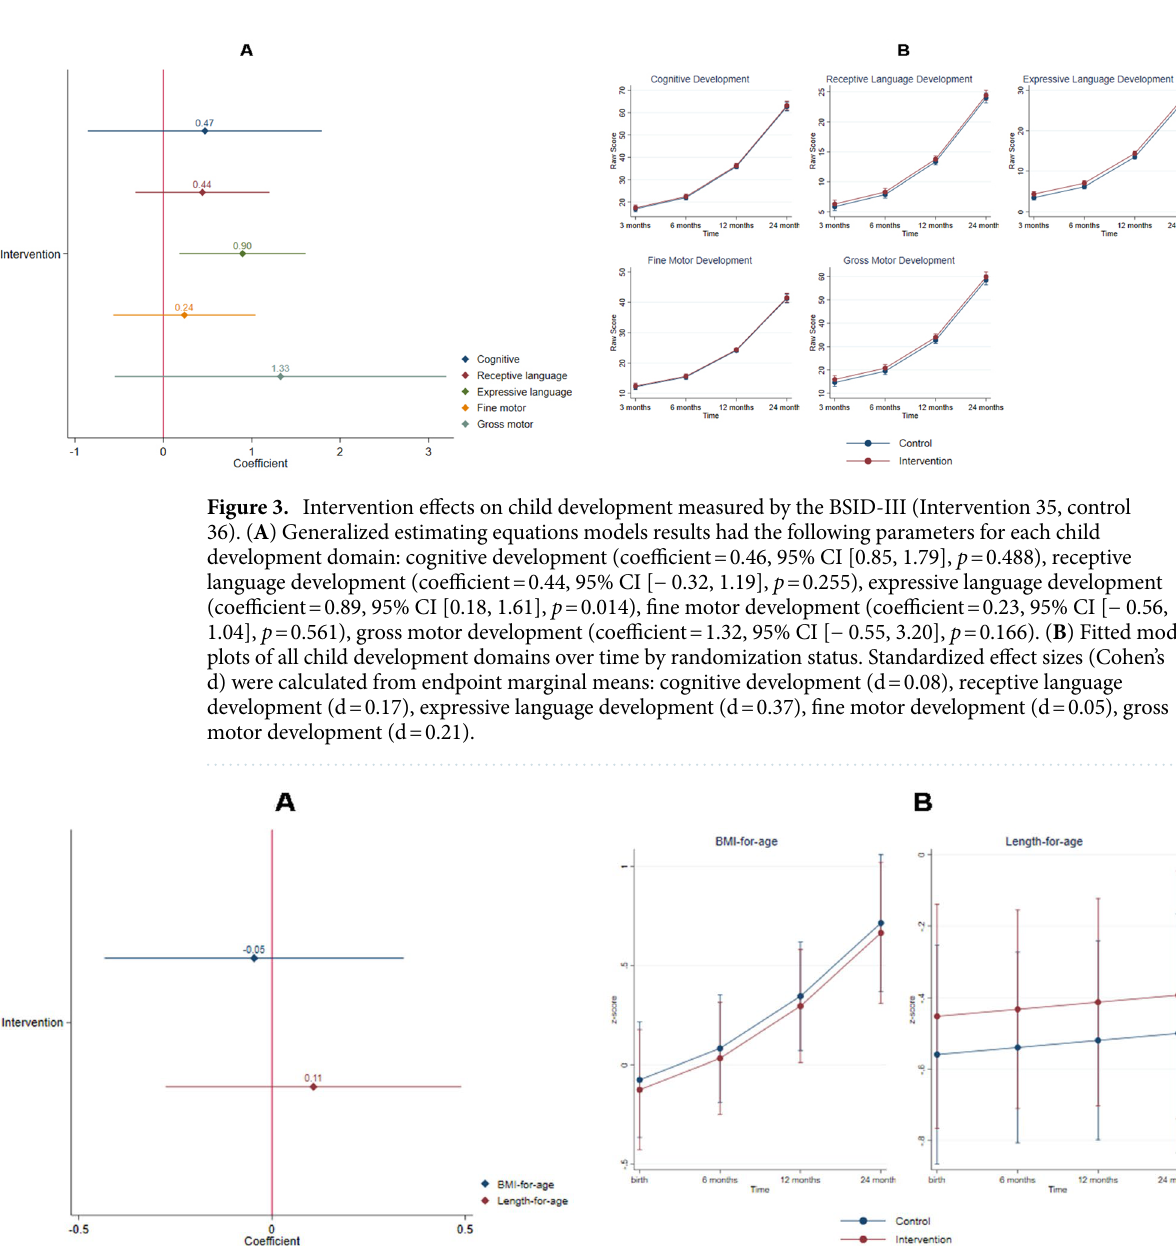
Figure 4. Intervention effects on anthropometric development (BMI-for-age: intervention n = 36, control n = 39; Length-for-age: intervention n = 35, control n = 37). ( A ) Generalized estimating equations models results had the following parameters for each child anthropometric development measure: BMI-for-age (coefficient = − 0.05, 95% CI [− 0.44, 0.34], p = 0.800), length-for-age (coefficient = 0.10, 95% CI [− 0.27, 0.49], p = 0.583). ( B ) Fitted models plots of all child development domains over time by randomization status. Standardized effect sizes (Cohen’s d) were calculated from endpoint marginal means: BMI-for-age (d = − 0.05), length-for-age (d =